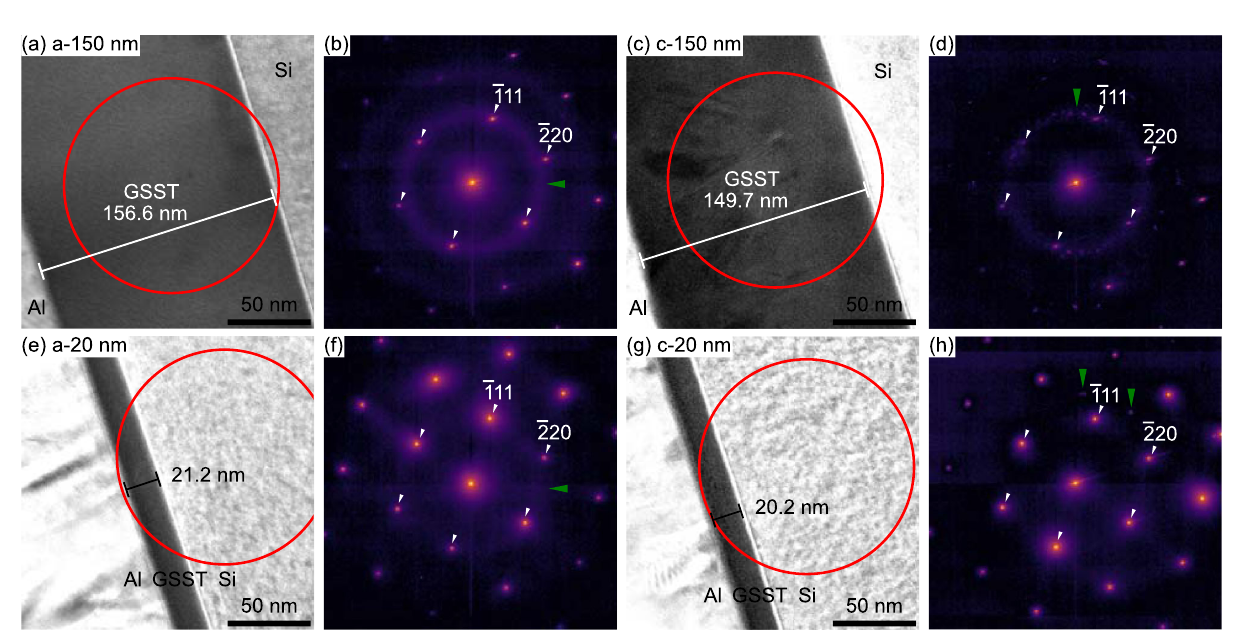
Fig. 1 The structure and thickness variation in GSST upon phase transformation. Bright- fi eld TEM images and the selected area electron diffraction patterns for 150 nm ( a , b , c , d ) and 20 nm ( e , f , g , h ) fi lms in amorphous and crystalline phases. Red circles indicate the selected area where diffraction patterns are acquired. In all cases, the selected area aperture includes the Si substrate. In diffraction patterns ( b , d , f , h ), white arrows indicate fi rst-order re fl ections from the Si substrate and the green arrows point to the fi rst-order GSST ( b , f ) amorphous ring, d polycrystalline ring, and isolated re fl